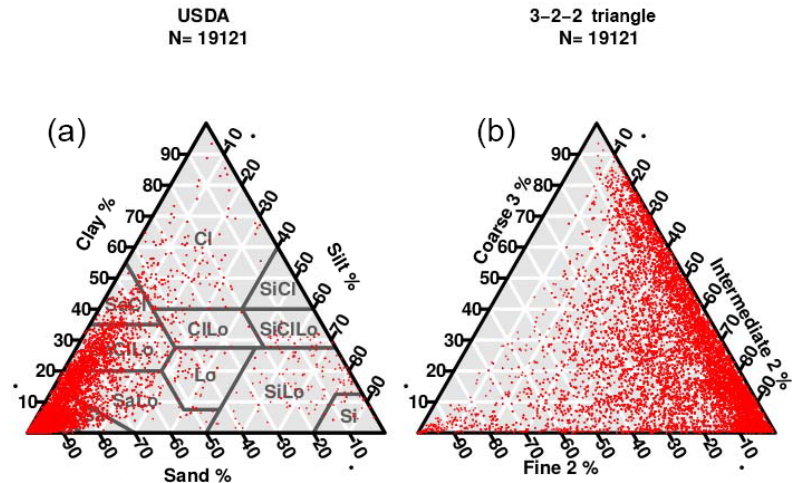
Figure 3. Representation in the USDA textural triangle of the 19193 soils used in this study. (a) Standard sand–silt–clay, i.e. “5-1-1” triplet. (b) The “3-2-2”